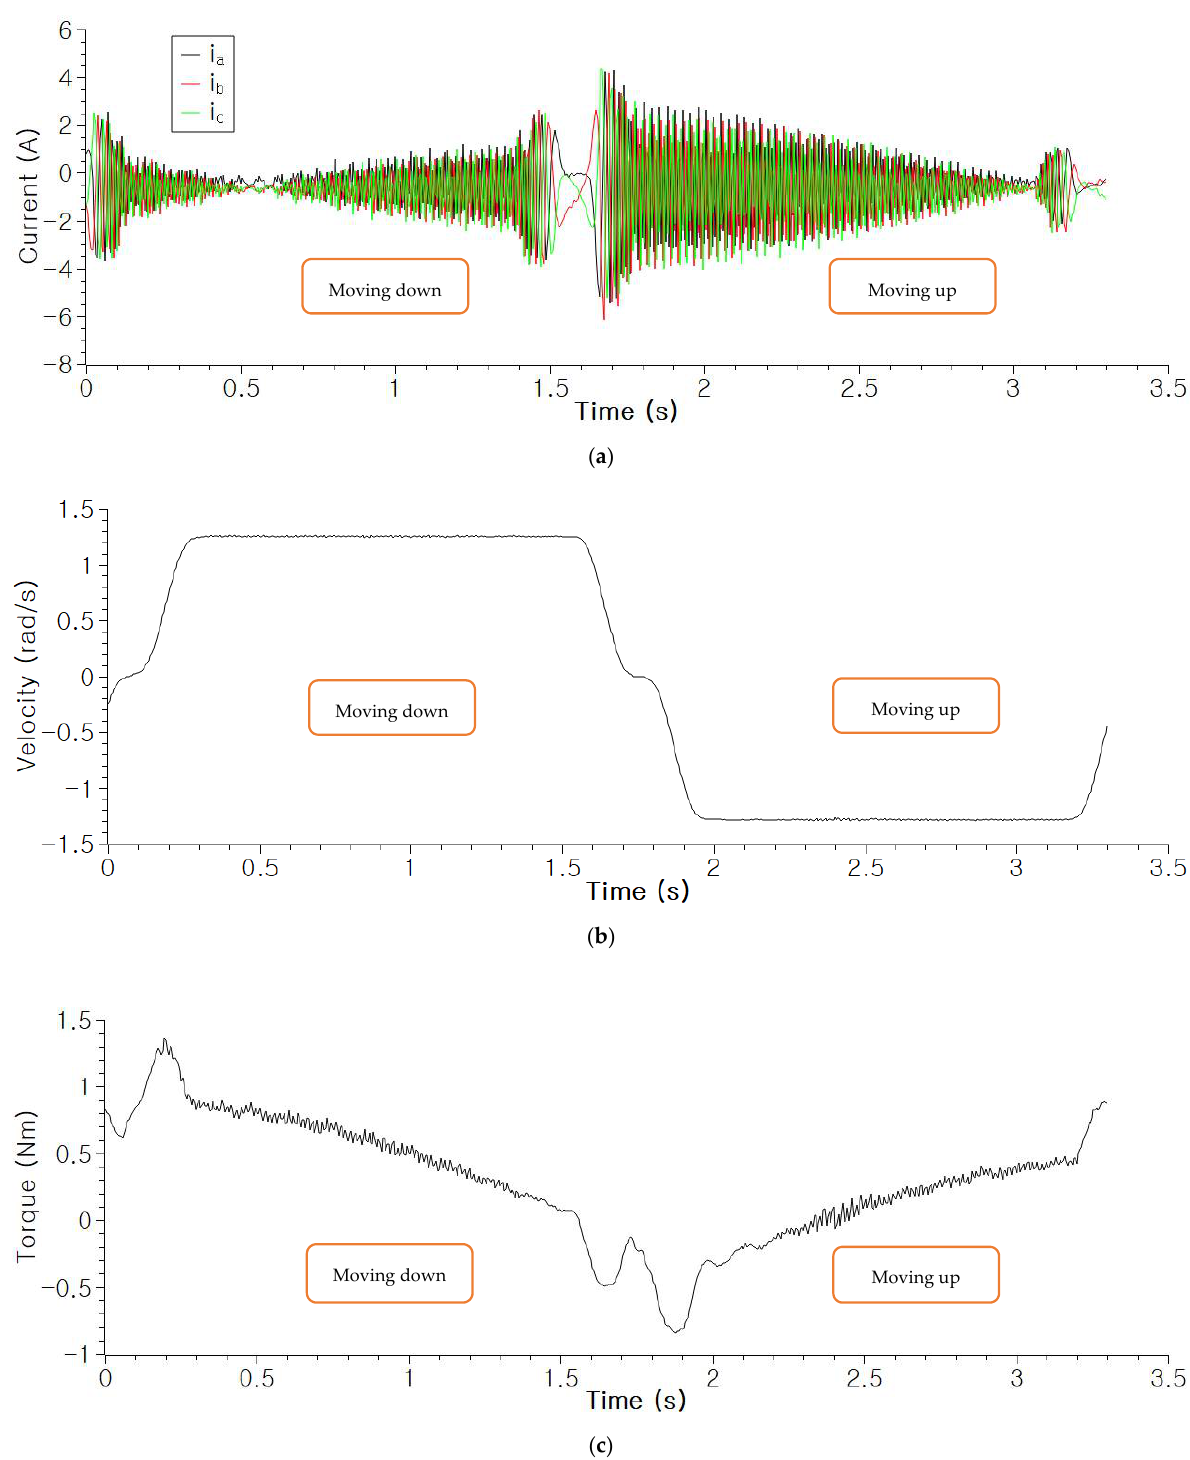
Figure 8. The waveforms of the three-phase currents measured from the moving manipulator (down and up). The measured signal having varying frequency (speed), phase sequence (rotational direction), and current amplitude (torque): ( a ) Measured three-phase currents (down and up); ( b ) Change in the rotational speed and direction calculated from ( a ); ( c ) Change in the torque calculated from ( a